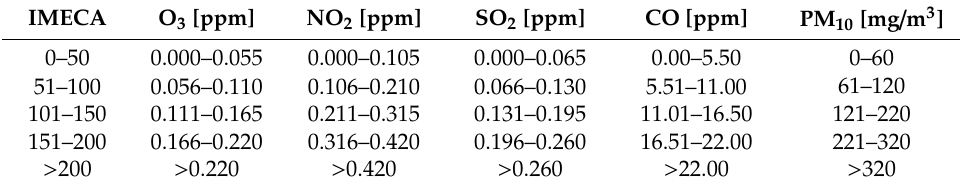
Table 1. Concentration intervals for color assignment or air quality levels [24].